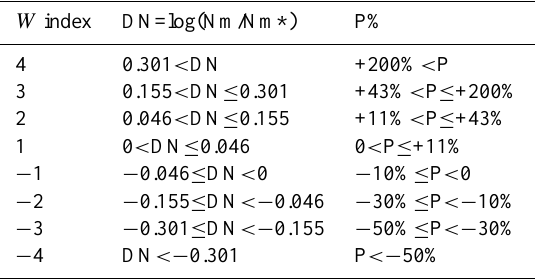
Fig. 4. The ionospheric weather index at Wakkanai during 3 days of ionospheric storm on 14–16 December 2006. W = ± 1 (blue), W = ± 2 (green), W = ± 3 (yellow), W = ± 4 (red). Equatorial D s t index (bot- tom panel). Table 3. Ionospheric weather index, relevant thresholds of loga- rithmic deviations and corresponding percentage changes in the F2 layer critical frequency foF2.